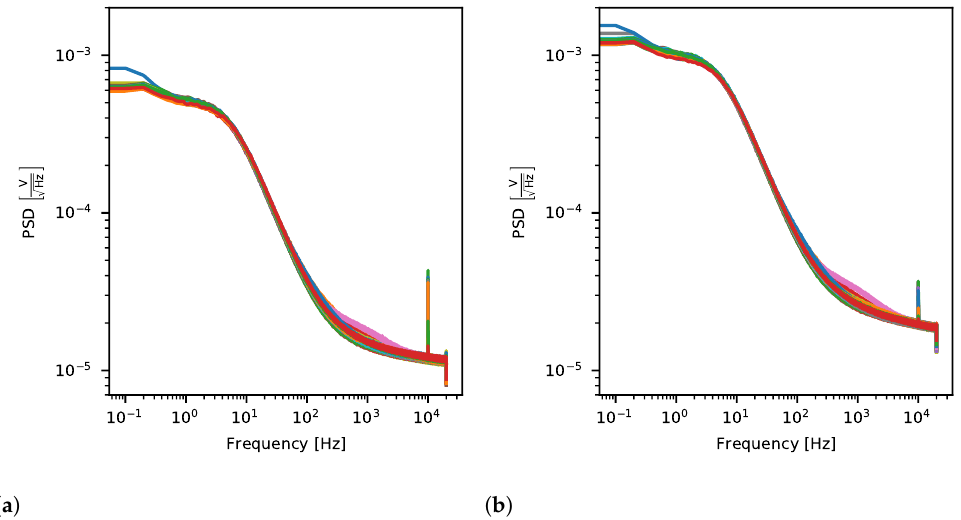
Figure 22. Power Spectral Density for all Neurostim-3 ASIC channels and gain ( a ) g = 250 ( b ) g =